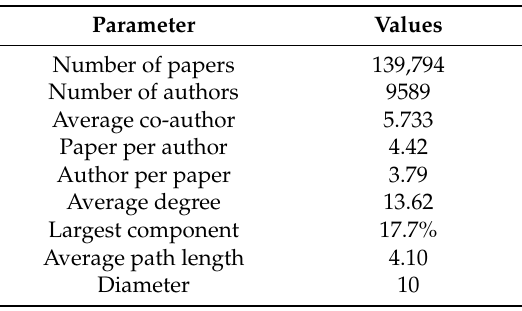
Table 2. Statistics of the DBLP co-authorship